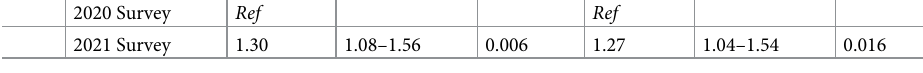
Adjusted Odds Ratio. � Model adjusted for all the covariates reported in Table